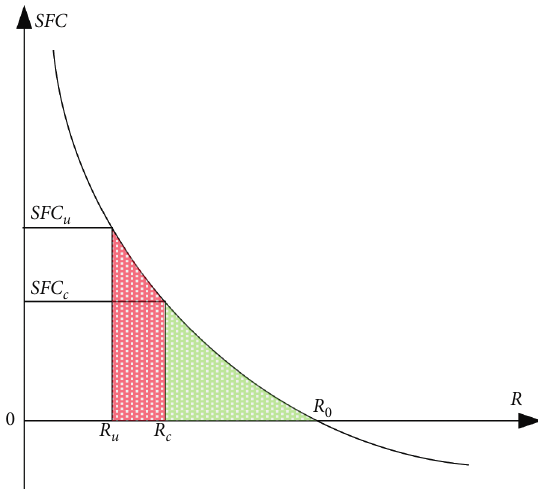
Figure 2: The relationship between SFC and R in scenic road curve